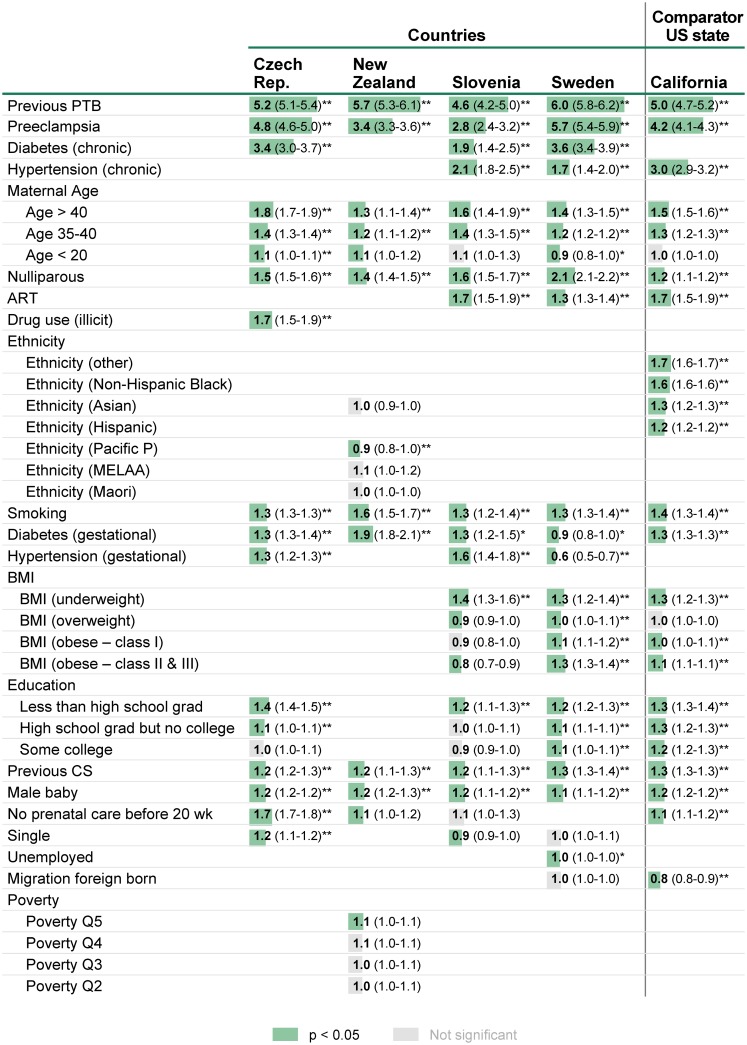
Risk factors for preterm birth across four countries and one comparator U.S. state.The odds ratios for each risk factor were calculated using five independent logistic regression models. Statistical significance was defined as p < 0.05. The width of the shaded lines are proportional to the reported odds ratios. A missing value indicates that data on risk factor were not available. For categorical variables, the reference categories were age 20–34 (age), non-Hispanic white (ethnicity), healthy BMI (BMI 18.5–24.9), highest education (college graduate or more), least deprived (poverty quintile Q1). Abbreviations: BMI, body mass index; MELAA, Middle Eastern, Latin American or African; PTB, preterm birth; ART, assisted reproductive technology; CS, cesarean section; 20wk, 20 weeks; Pacific P, Pacific people; * p<0.05; ** p<0.01